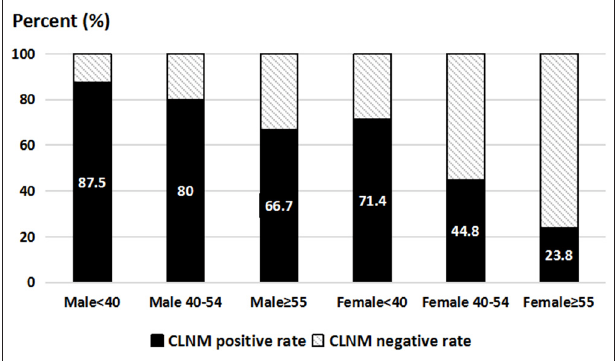
FIGURE 2 | Central-compartment lymph node metastasis rate according to sex and